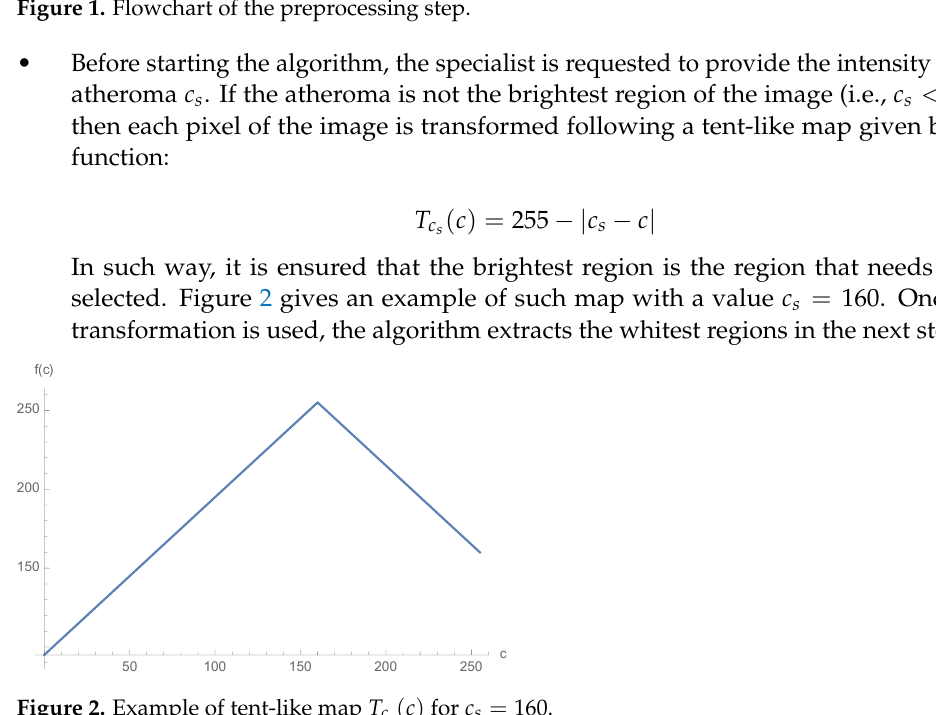
Figure 2. Example of tent-like map T c